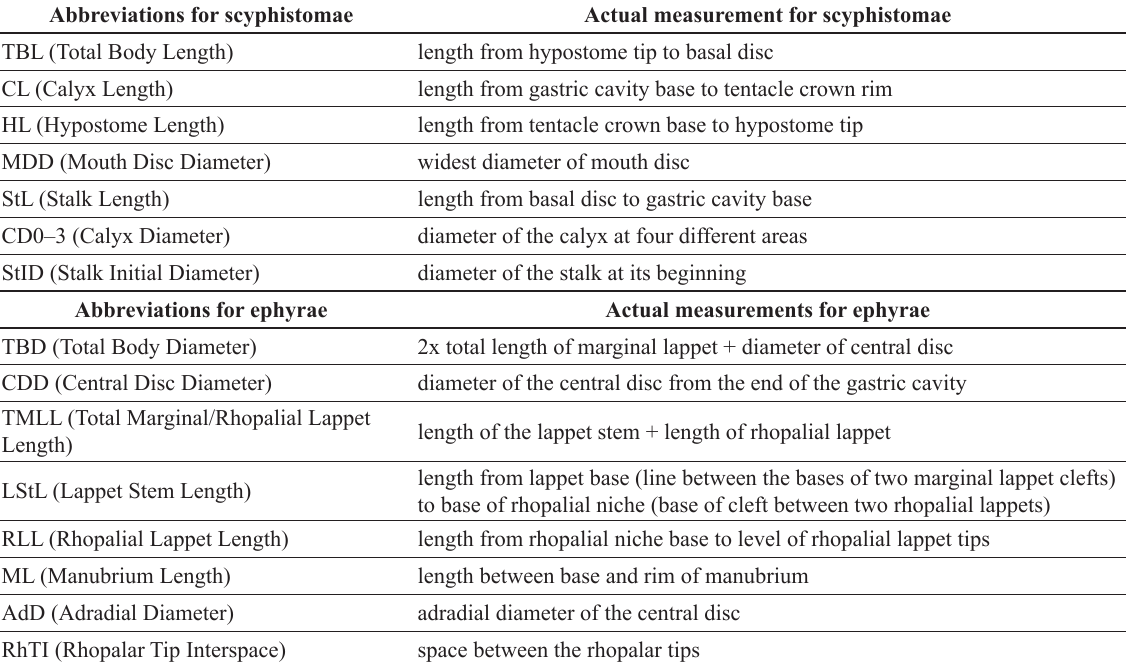
Table 2. Measuring parameters for scyphistomae and ephyrae mainly according to Straehler-Pohl (2009), Straehler-Pohl & Jarms (2010) and Straehler-Pohl et al.